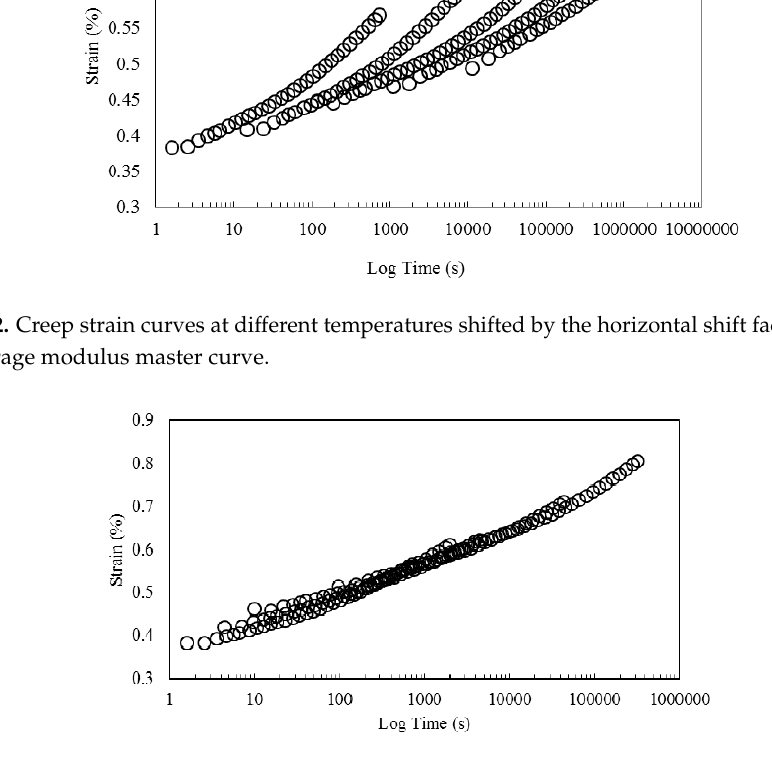
Figure 13. Creep strain master curve generated by horizontal and vertical shift factors.